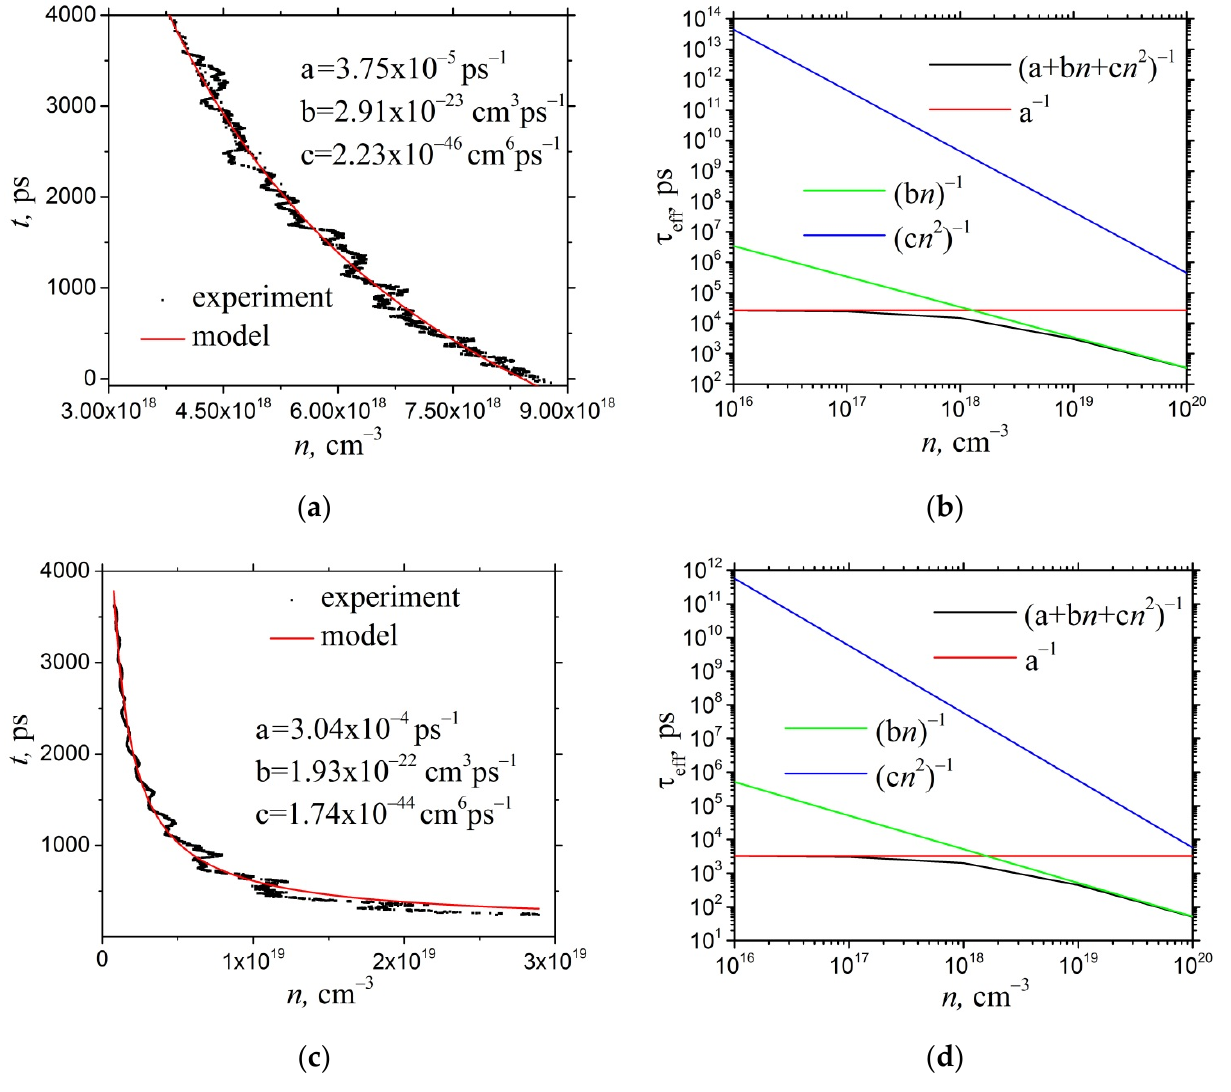
Figure 3. The experimental and fitting (the parameters are indicated) time dependences of the nonequilibrium charge carrier concentration ( a ) in initial SI GaAs:EL2 and ( c ) after grinding the surface; ( b , d ) related calculated injection level dependences of efficient charge carrier lifetime with the resolution into contributions from different recombination